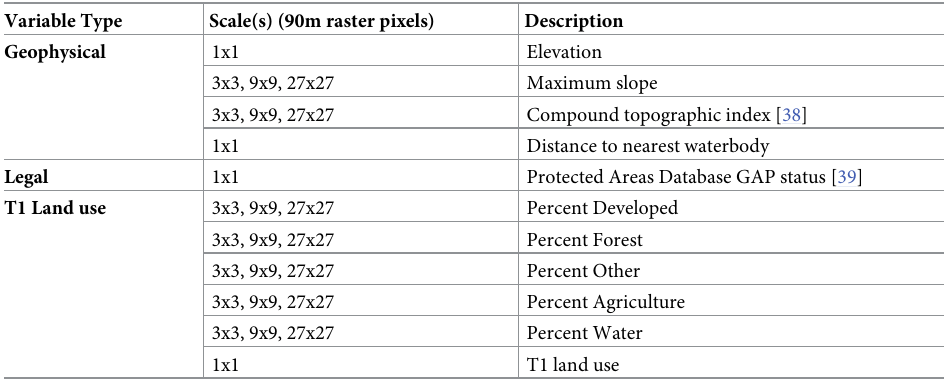
Table 2. Ancillary datasets used to model transition probabilities.